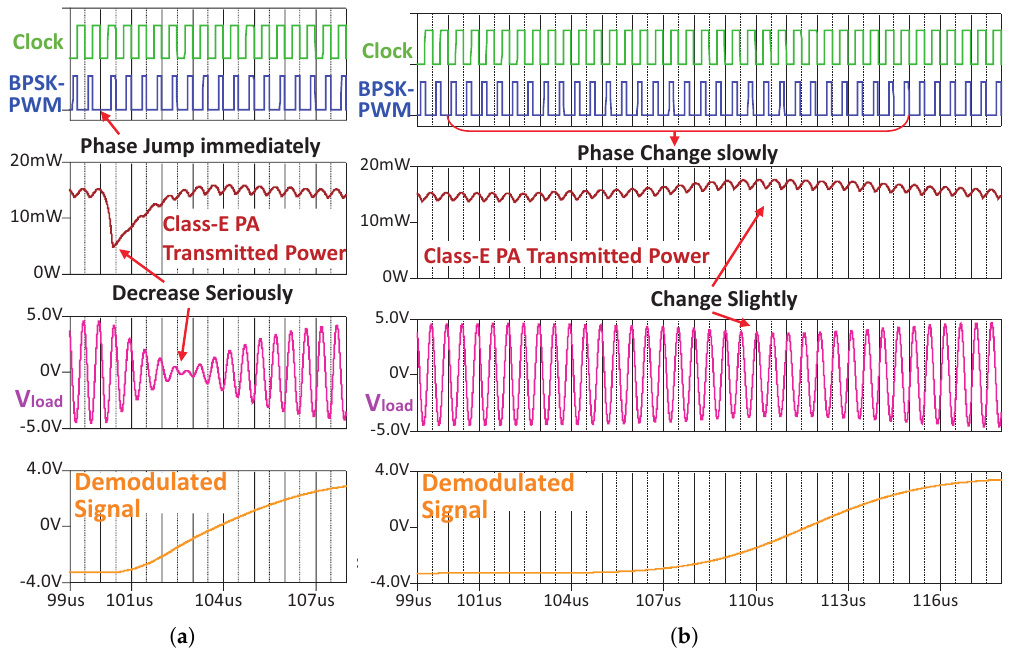
Figure 9. Downlink waves recorded from PSpice simulation, when the BPSK is modulated on the power link ( a ) without using the shaping filter and ( b ) with using the shaping